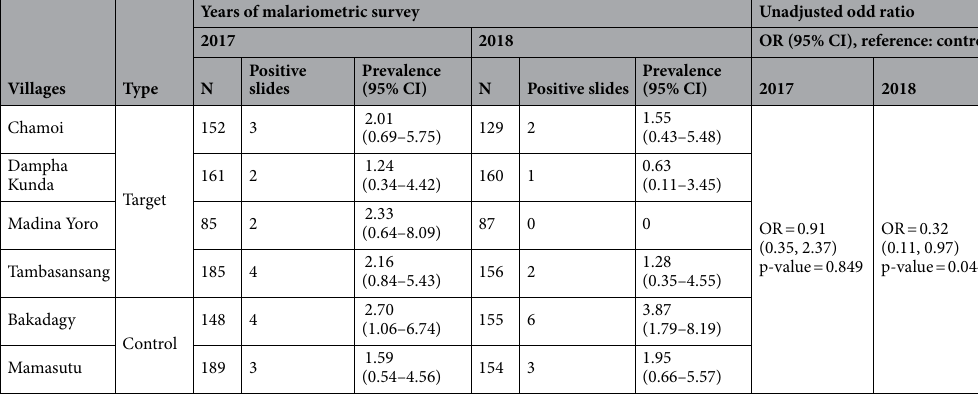
Years of malariometric